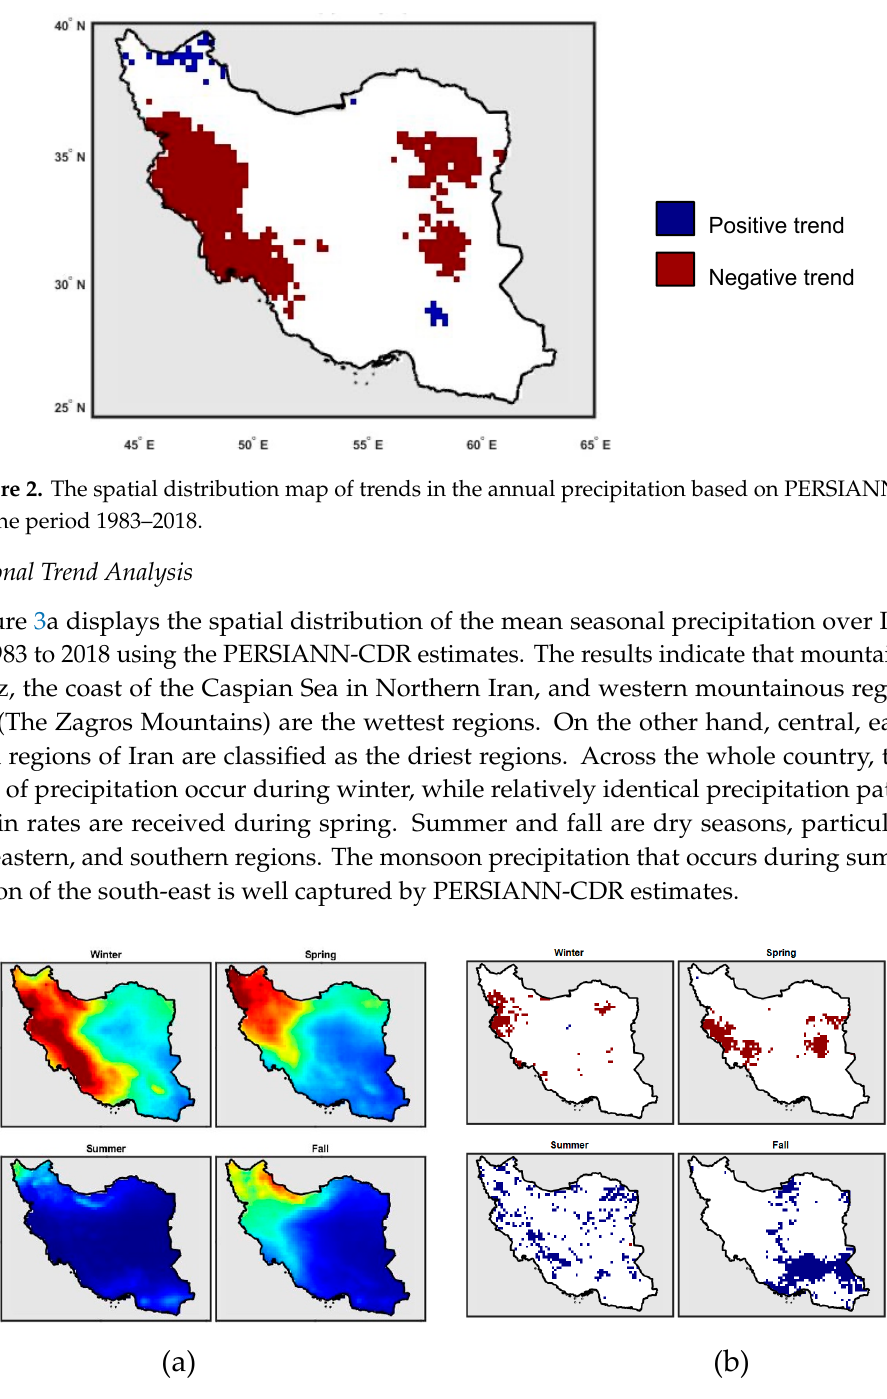
(b) Figure 4. ( a ) Spatial contribution map for each season to annual precipitation based on the climate data record of PERSIANN-CDR for the period 1983 to 2018; ( b ) spatial map for trend of the contribution of each season to annual precipitation. Figure 5 illustrates the spatial contribution map for each season to annual precipitation based on climate data record of PERSIANN-CDR for dry and wet years. The results show that mostly the central, southern, and eastern regions receive more than half of winter rainfall for both dry and wet years. However, the northeast of Iran receives more than half of the annual rainfall during winter in